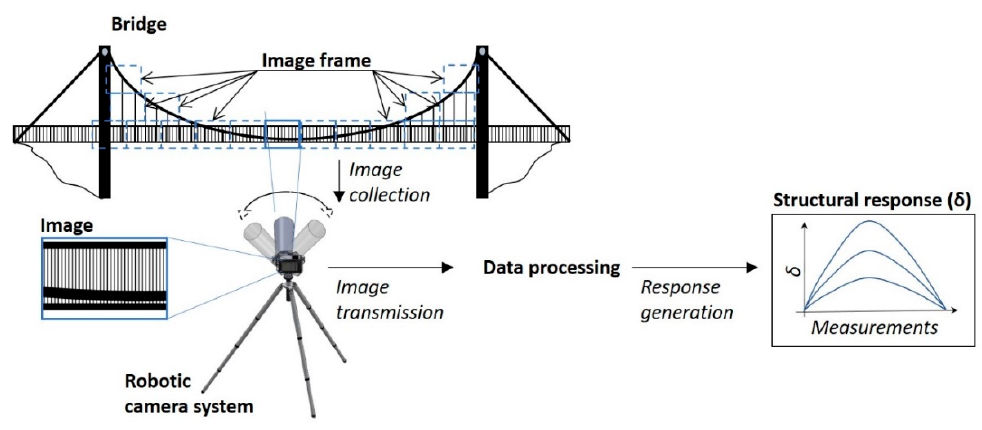
Figure 1. A robotic camera system for structural response collection.